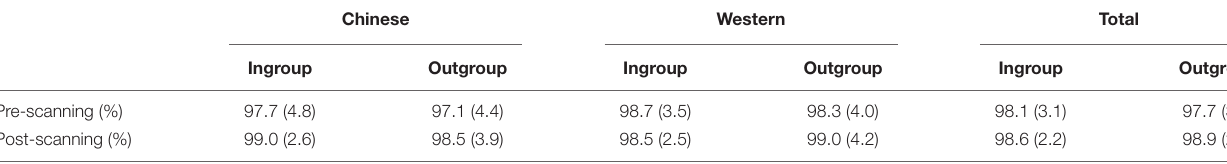
TABLE 1 | Mean response accuracy (SD) in pre- and post-scanning categorization test ( N = 29).